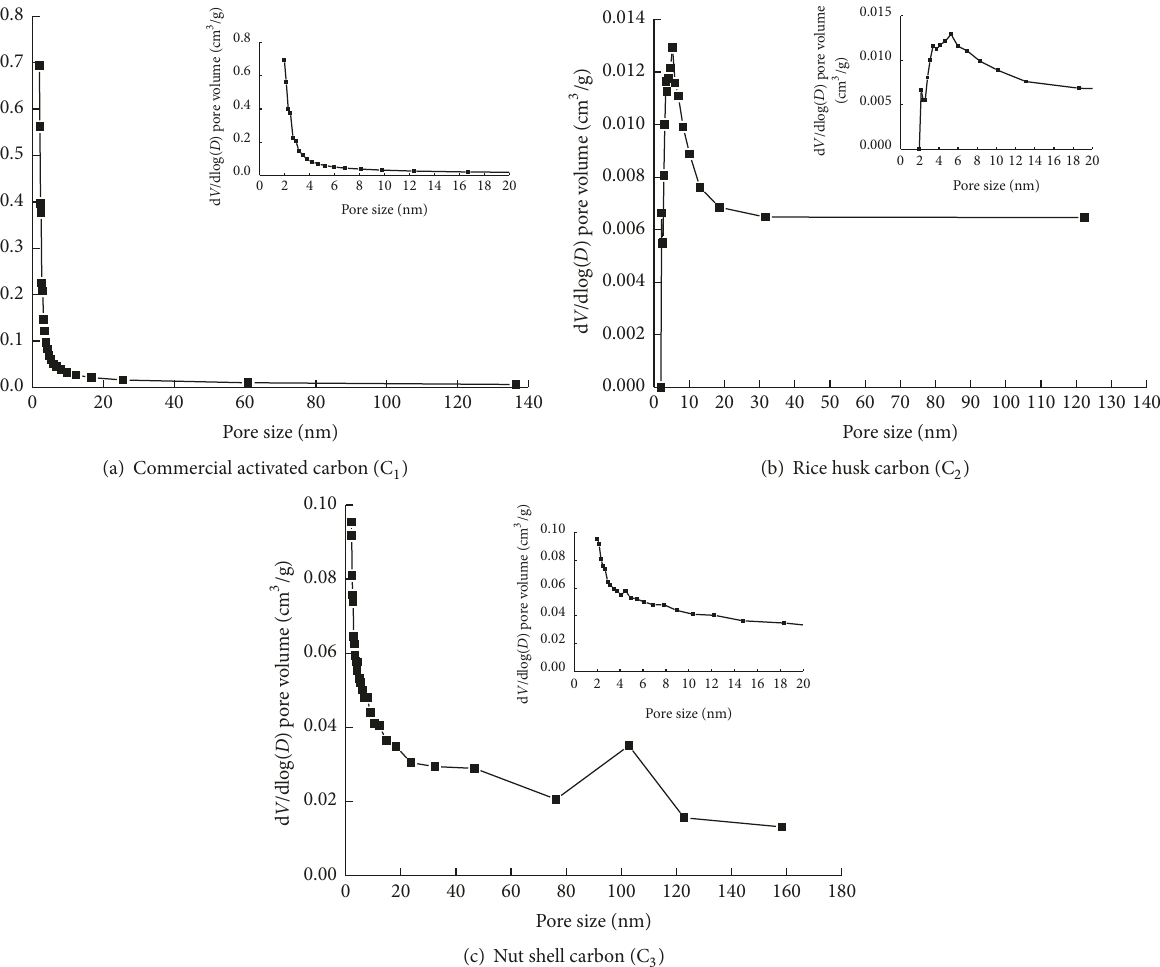
Figure 1: Pore size distribution curves of commercial activated carbon (C 1 ), rice husk carbon (C 2 ), and nut shell carbon (C 3 ).